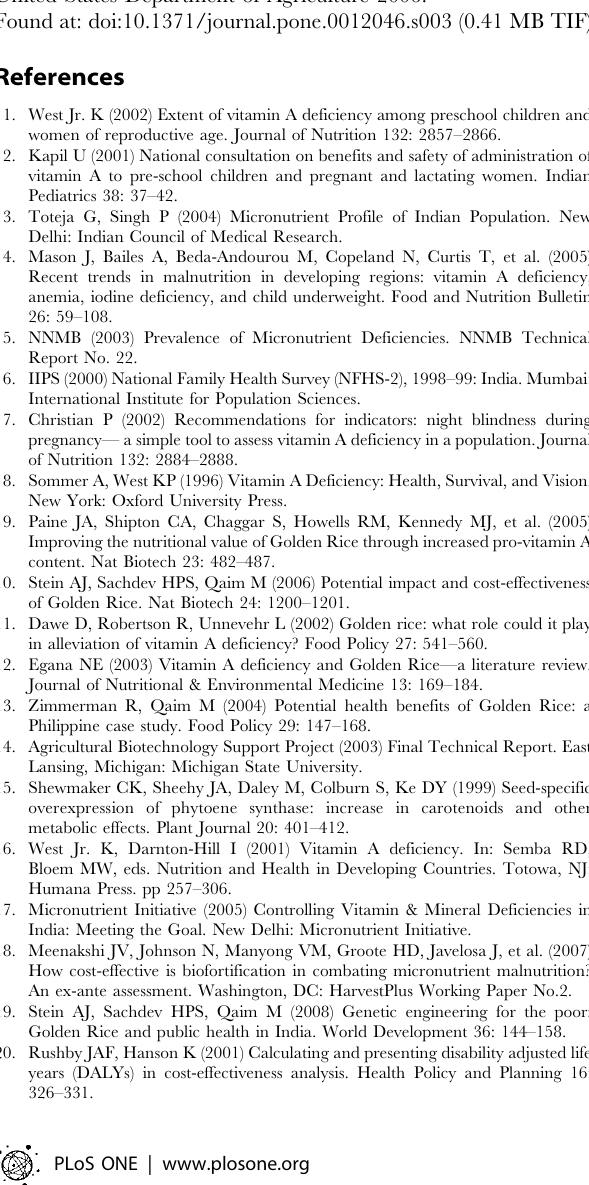
Figure S2 Monthly per capita purchases of mustard oil by household income in rural and urban households of Rajasthan, Uttar Pradesh, Bihar, and Madhya Pradesh, 2005. Source: IMRB